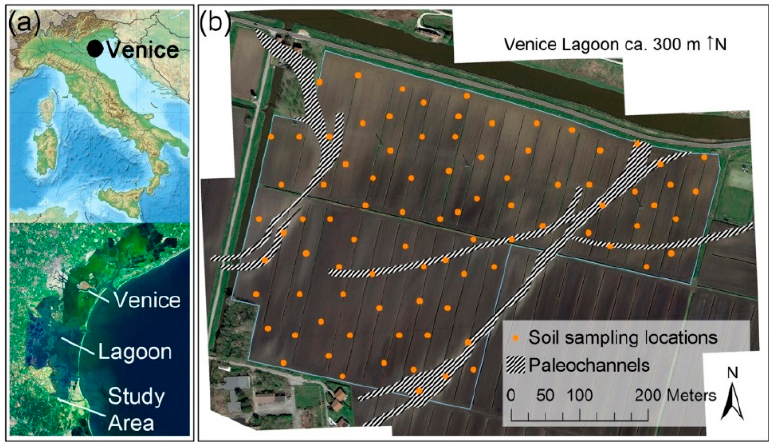
Figure 1. ( a ) Geographical location of the study area relatively to the Venice Lagoon, Italy, and ( b ) locations of soil sampling locations and coarsely textured paleochannels. Modified after Scudiero, Teatini, Corwin, Dal Ferro, Simonetti, and Morari